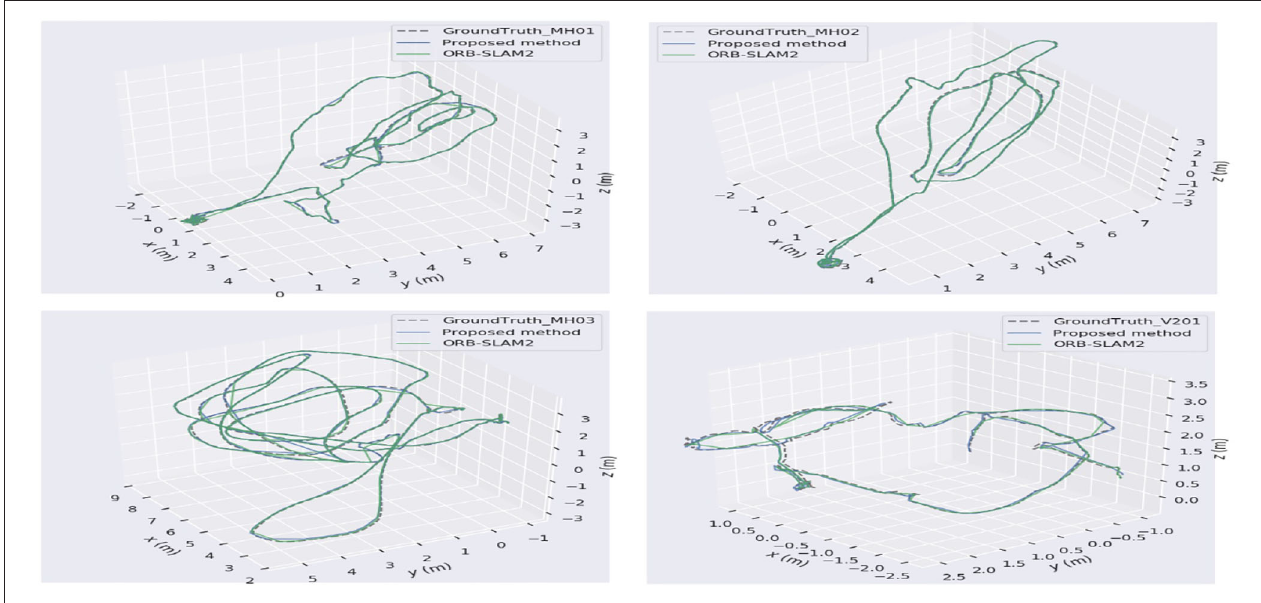
FIGURE 9 | Keyframe trajectory comparison on EuRoc datasets.